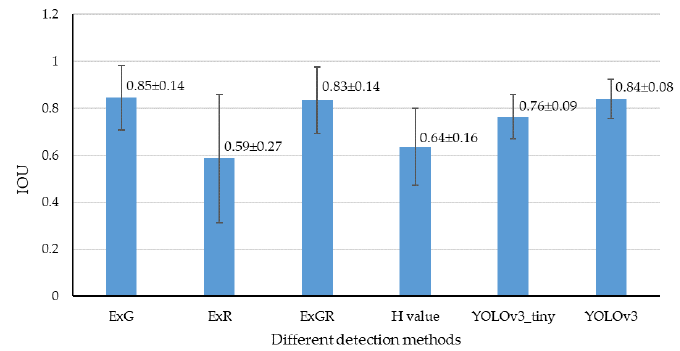
Figure 11. Localization accuracy comparison among different detection methods.